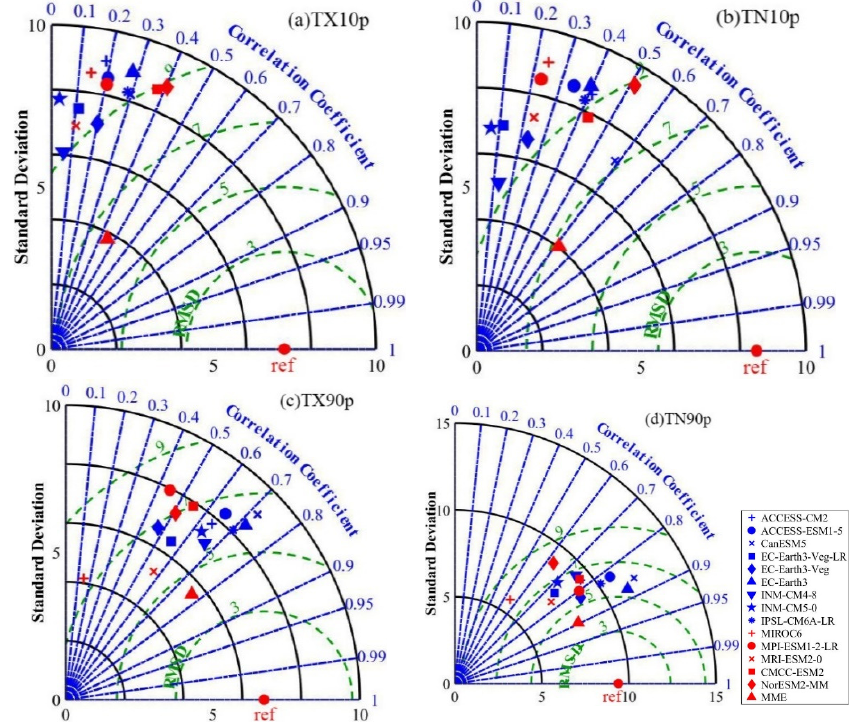
Figure 4. Taylor diagrams of TX10p ( a ), TN10p ( b ), TX90p ( c ), and TN90p ( d ) (ref is the extreme climate index calculated from historical observed values; MME represents the mean of 14 CMIP6 climate models).